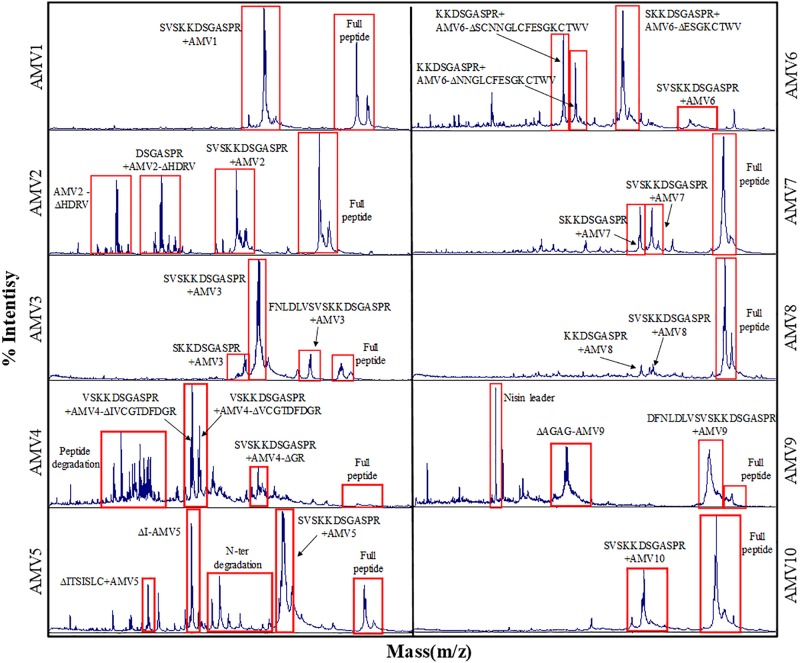
MALDI-ToF chromatogram for AMVx peptides indicating different degradation levels.